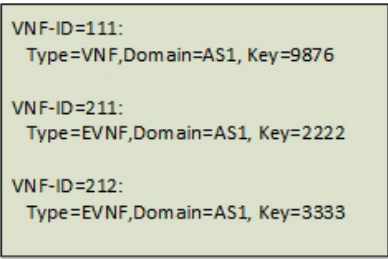
Figure 16. A Virtual Network Function provisioning